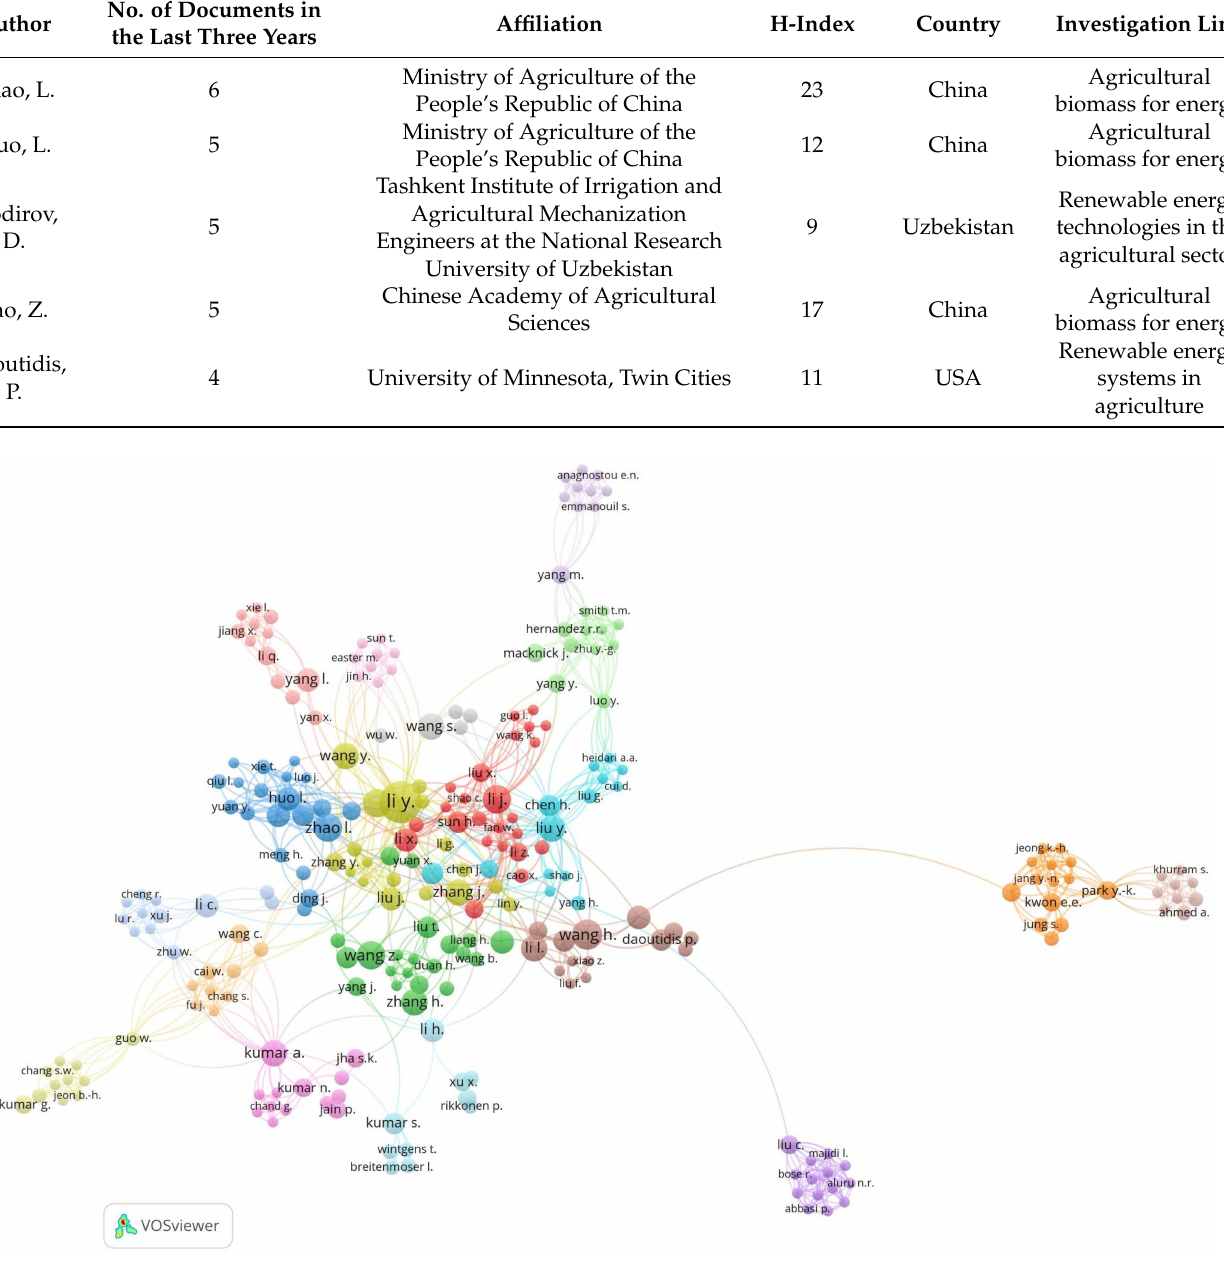
Figure 8. International scientific